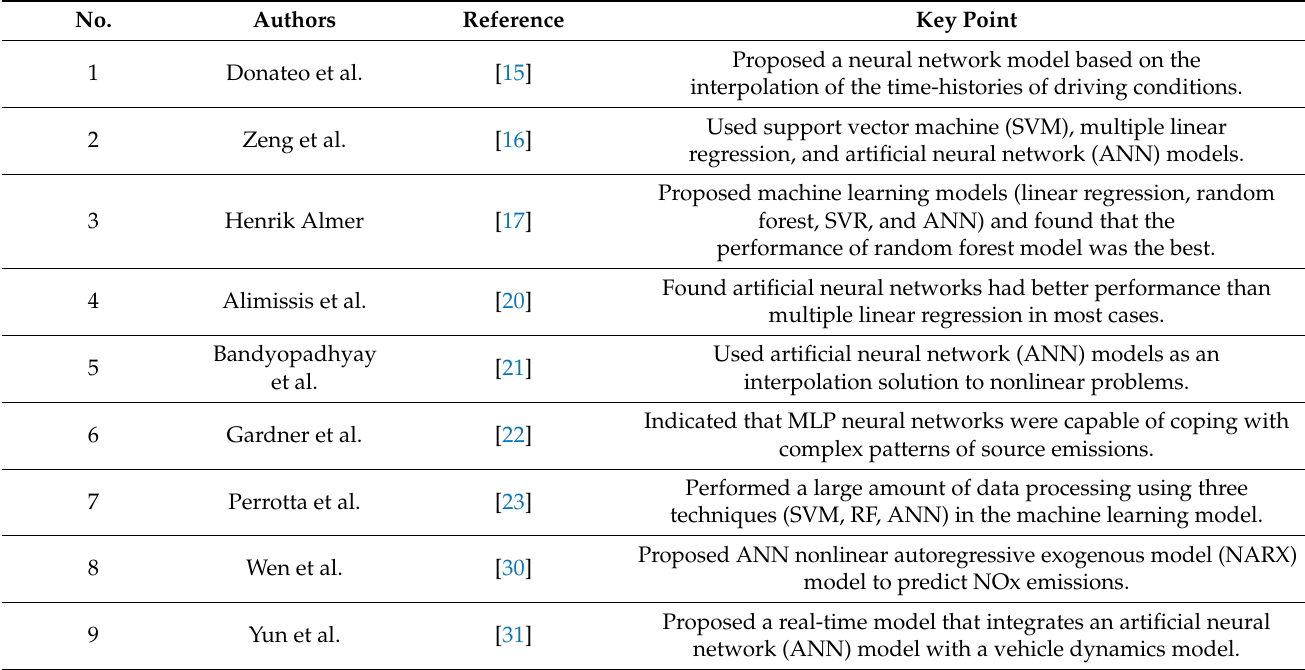
Table 1. Key point of each study in the literature